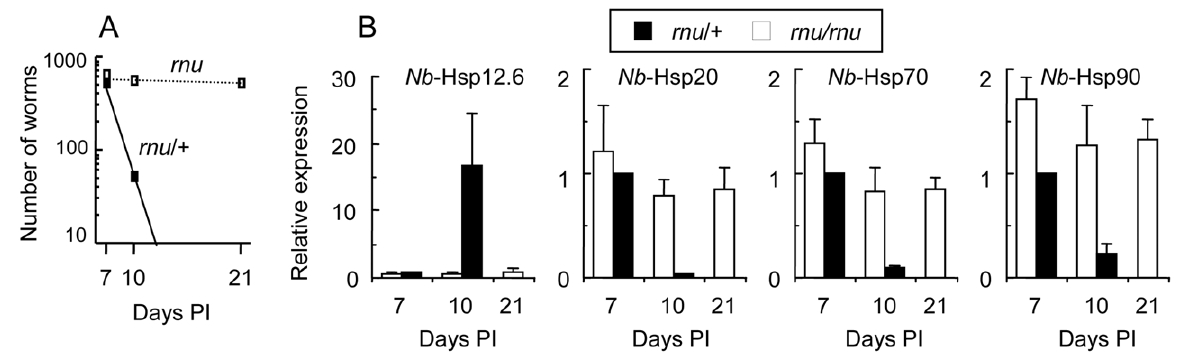
Figure 4. Hsp gene expression in adult worms in athymic rats. A . Worm burdens in the small intestine of athymic nude ( rnu/rnu ) (n=3/group) and euthymic rnu / + rats (n=3/group) after infection with 1,000 infective-L3 larvae. B , Hsp-gene expression levels of worms recovered from athymic and euthymic rats. For day 21, as all worms had been expelled from rnu / + rats, only data from rnu/rnu rats are shown. Gene expression levels were normalized to those of Nb -actin. The levels in worms recovered from euthymic rats at 7 days PI are expressed as 1.0.